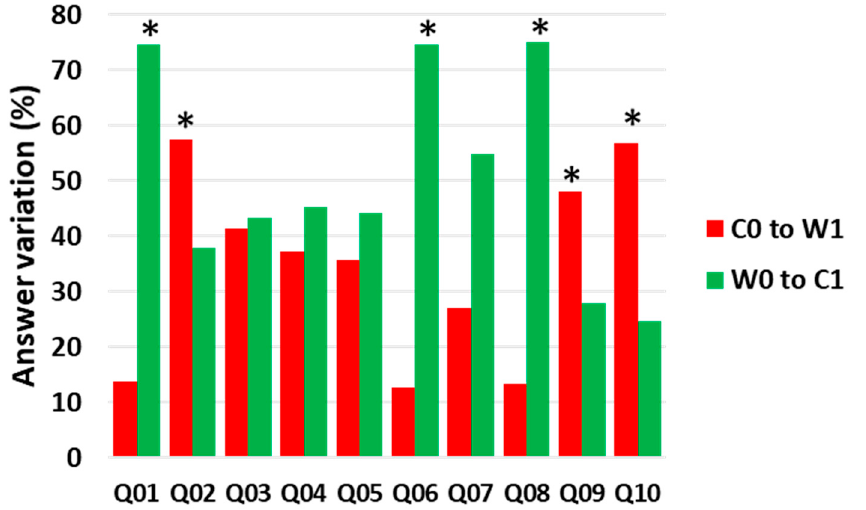
Figure 2. Answer variation to the questionnaires filled in at the end of the didactic path. Data rep-